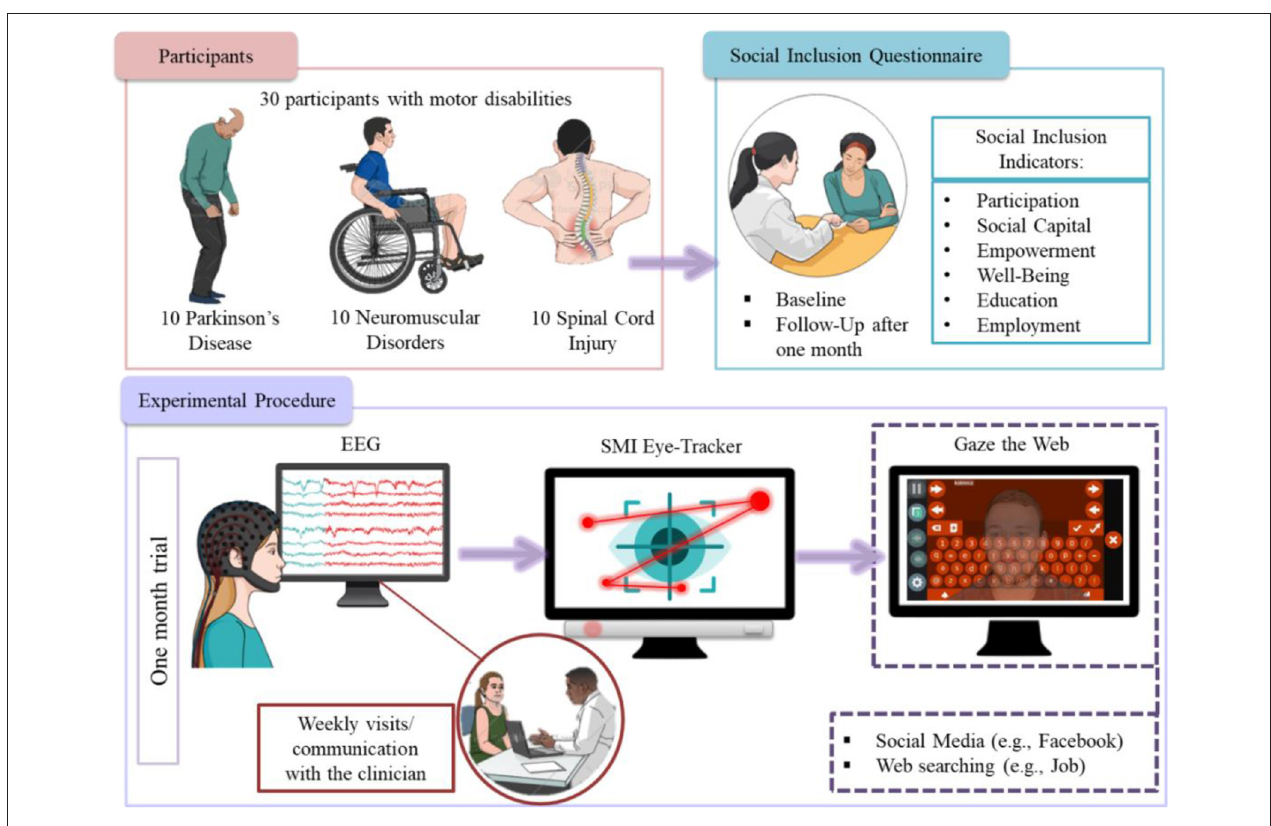
FIGURE 1 | Pipeline